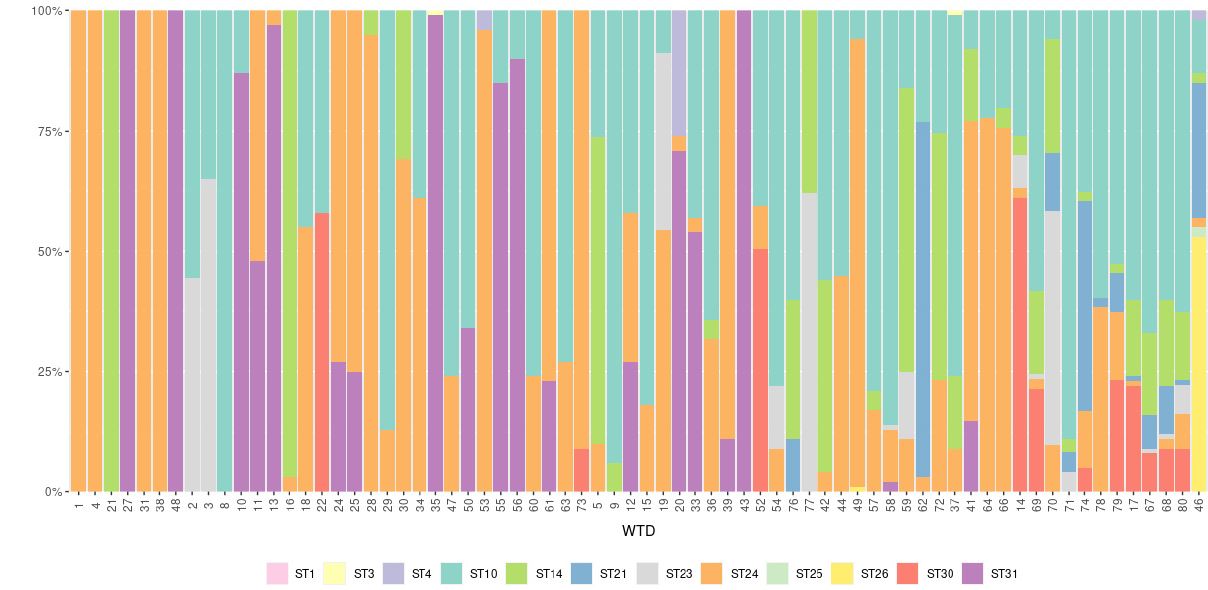
Figure 1. Relative abundance of reads (%) of each subtype present in the 71 Blastocystis -positive white-tailed deer (WTD) samples arranged by number of subtypes present from lowest to highest.